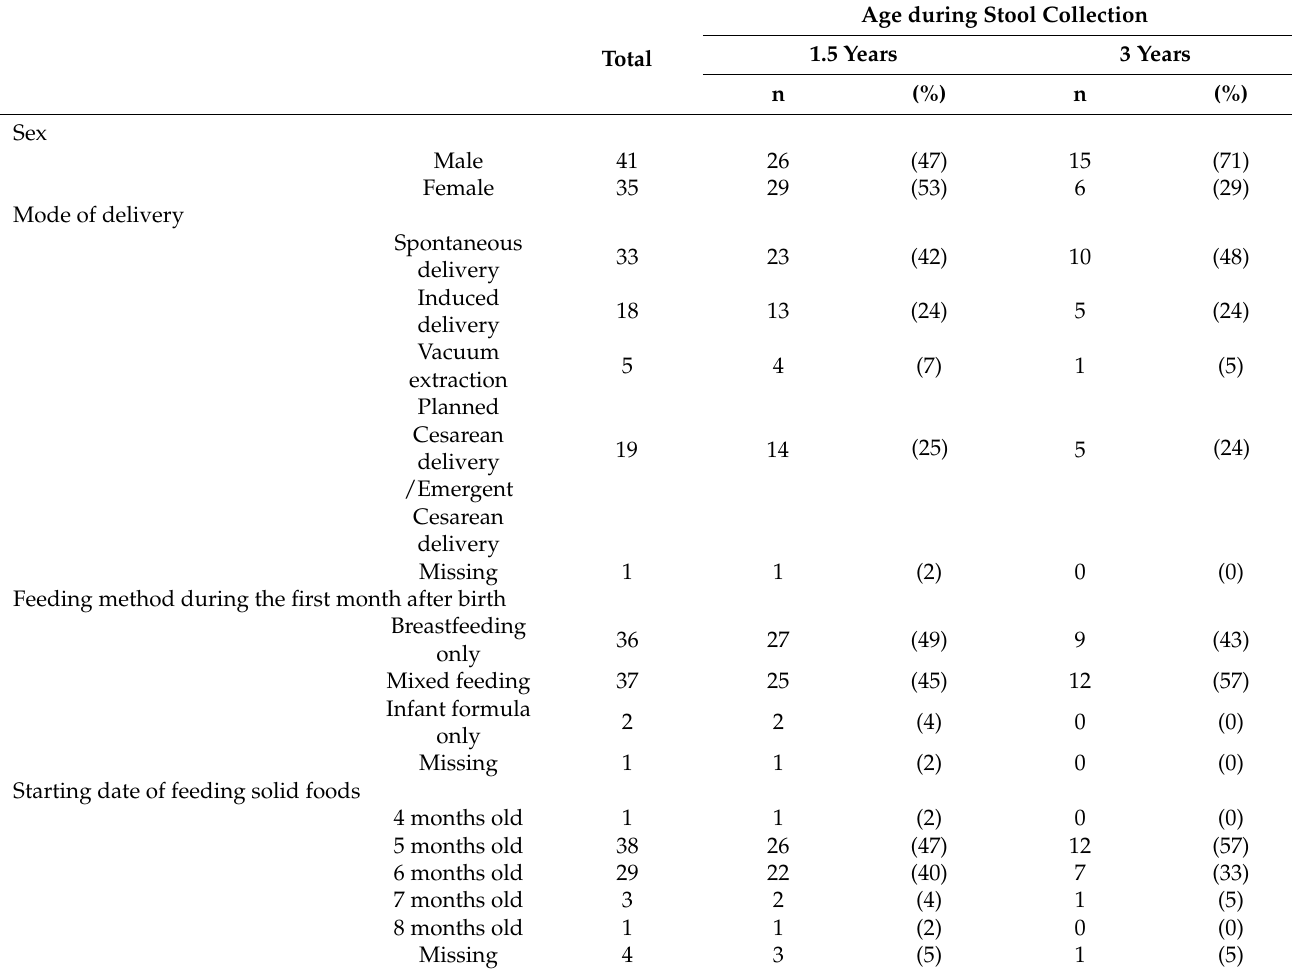
Table 1. Characteristics of the study participants in Research